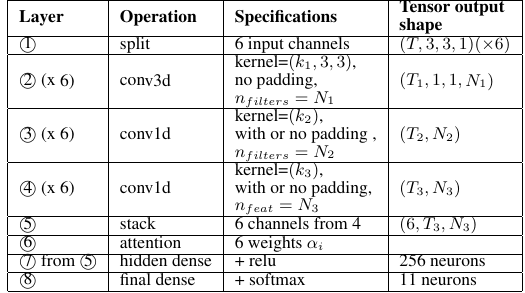
Table 1. DSLCC architecture. Features are extracted by 3 different convolutional layers computed for each one of the 6 channels (6 times layers 2 ⃝ , 3 ⃝ , 4 ⃝ ). Attention layer 6 ⃝ is outing 6 channel attention